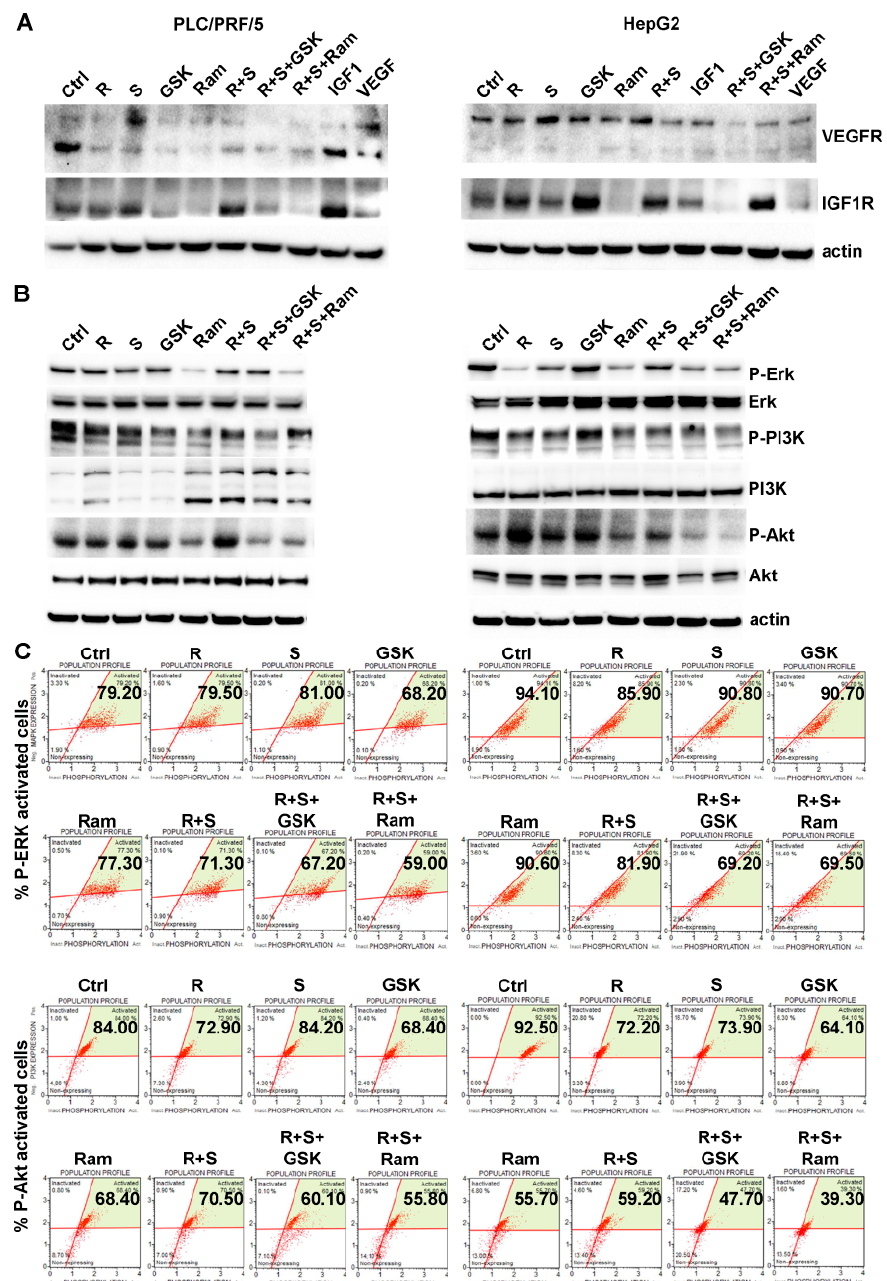
Figure 6. GSK1838705A and ramucirumab potentiate the inhibitory effects of sorafenib/regorafenib combination on the modulation of MAPK and PI3K/Akt signaling in HCC cells. Cells were cultured with 2.5 μ M (PLC/PRF/5) or 1 μ M (HepG2) sorafenib, 1 μ M (PLC/PRF/5) or 0.1 μ M (HepG2) regorafenib, 3 µ M GSK1838705A and 400 µ M ramucirumab administrated singularly or in combination. ( A ) In addition to the described treatments, IGF1 75 ng / mL and VEGF 20 ng / mL recombinant molecules were used as single treatment. Western blotting showing the expression levels of VEGFR and IGF1R after 48 h of single or combined treatments. ( B ) Western blotting showing the expression levels of phosphorylated Erk, PI3K and Akt relative to the total protein expression after 48h of single or combined treatments. ( C ) The Muse Activation Kits were used to evaluate the ERK and Akt phosphorylation relative to the total protein expression after 15 min and 24 h respectively. An example of ERK and Akt activation status after each drug treatment conditions are shown in the relative